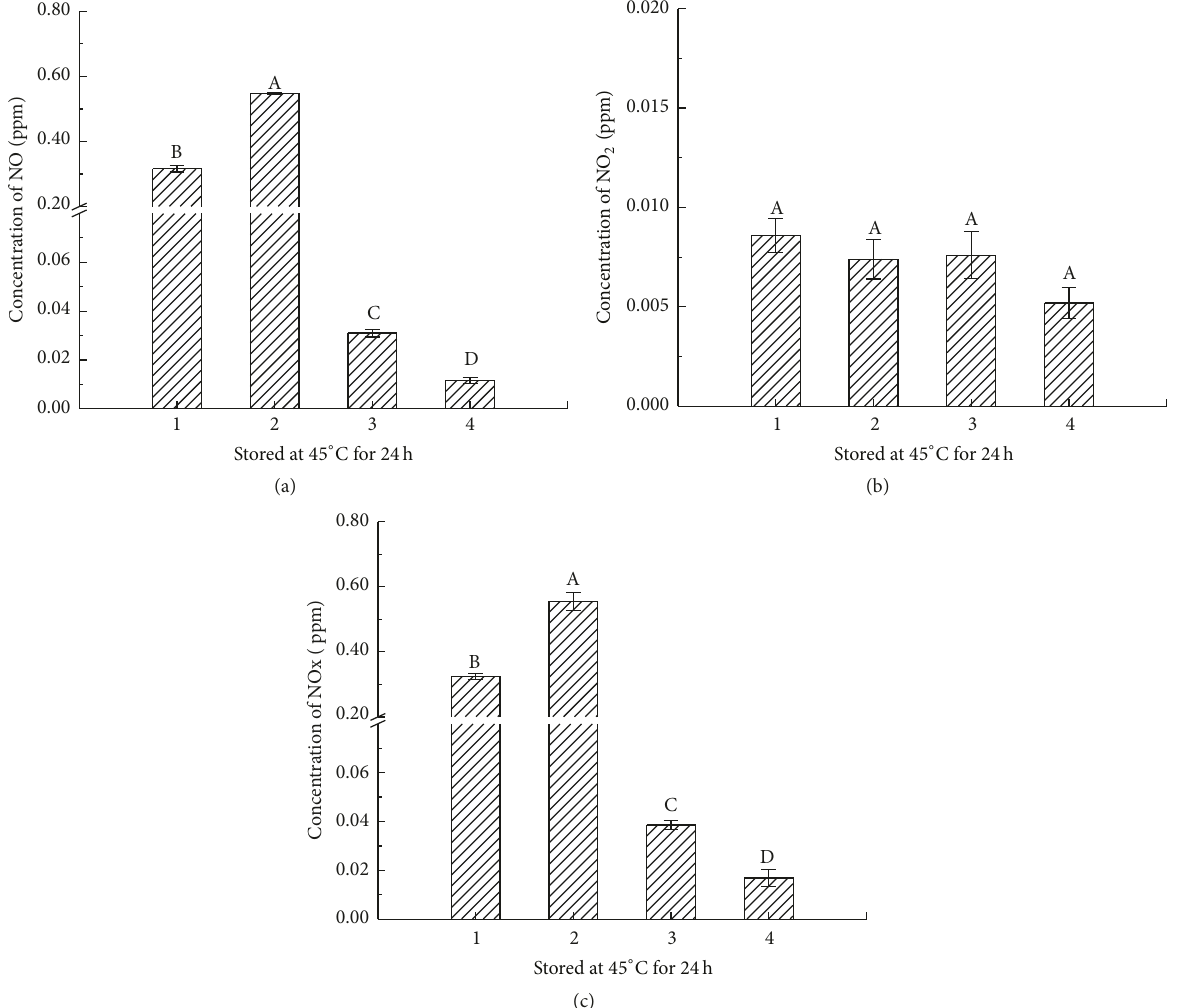
Figure 5: Effect of indirect addition of nitrate and activated carbon (AC) on nitrogen oxides formation in a closed system with flue-cured tobacco. Note . (1) tobacco, (2) tobacco + NaNO 3 , (3) tobacco + NaNO 3 + AC 2.0 g, and (4) tobacco + NaNO 3 + AC 10.0g, 40 g of flue-cured tobacco, and 0.8g NaNO 3 (583 mg of NO 3− ). The NO 3− , AC, and tobacco were added separately in the vacuum desiccators stored at 45 ∘ C for 24 h. Uppercase letters indicate significant differences between the treatments at 𝑃 < 0.05